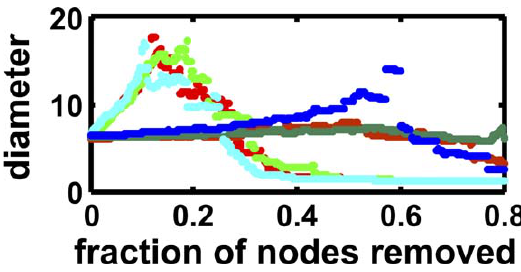
Figure 4. Average Diameter (Path Length) under Node Removal Average network diameter at depth 5,000 under node removal, for the functional network. Light colored dots, path length with removal of hubs; dark colored dots, path length with removal of random nodes; green, static environment; blue, quasi-static; and red, dynamic environ- ment. The breakdown under hub removal comes at about 200 hubs